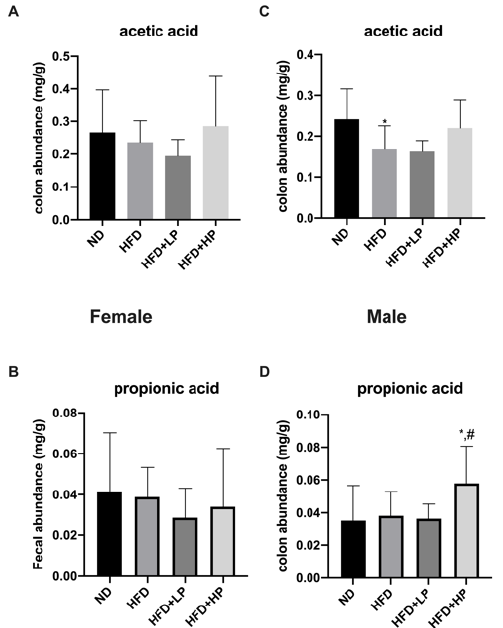
Figure 7. The modulation of main colon short-chain fatty acid (SCFA) concentrations responded to HFD and CP administration in female mice ( A , B ) and male mice ( C , D ). Data are presented as the mean ± SD.